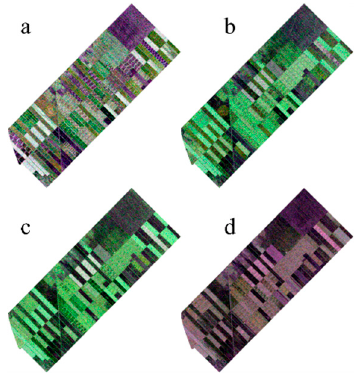
Figure 1. Test site (R/G/B: HH/VH/VV).